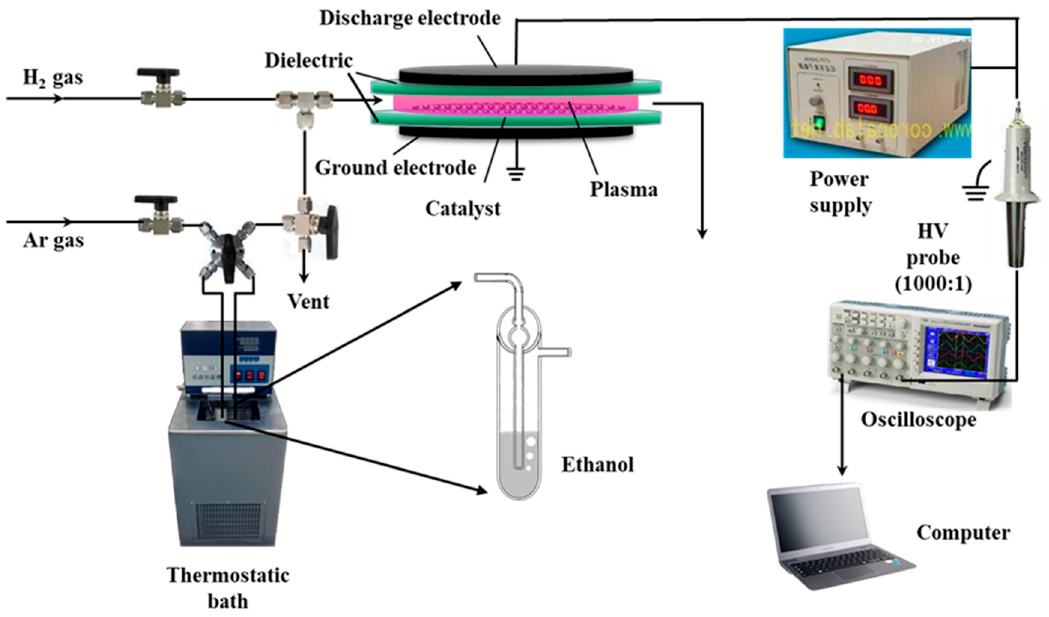
Figure 1. Schematic of atmospheric-pressure ethanol cold plasma treatment for the preparation of Pd/C catalytic materials.